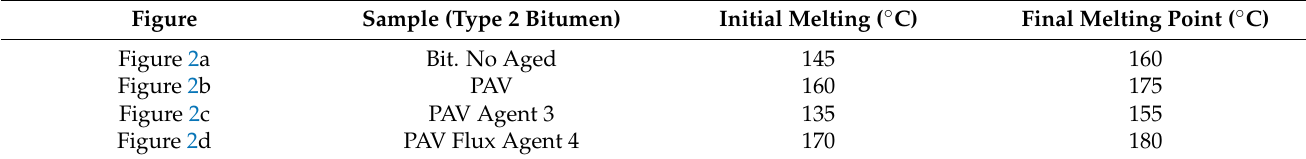
Table 3. Melting point of the aged and non-aged samples. Figure Sample (Type 2 Bitumen) Initial Melting ( ◦ C) Final Melting Point ( ◦ C) Figure 2a Bit. No Aged Figure 2b Figure 2c PAV Agent 3 155 Figure 2d PAV Flux Agent 4 170